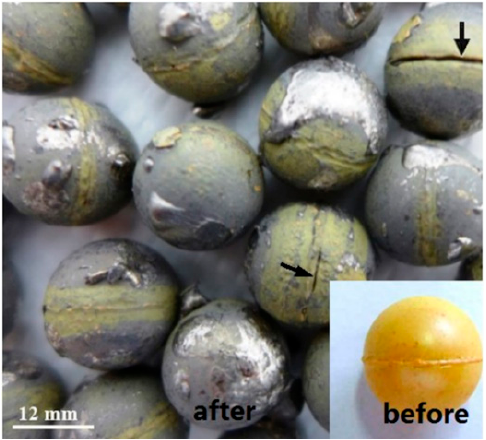
Figure 1. PbO ceramic pellets tested in the CRAFT loop and MEXICO loop [5].